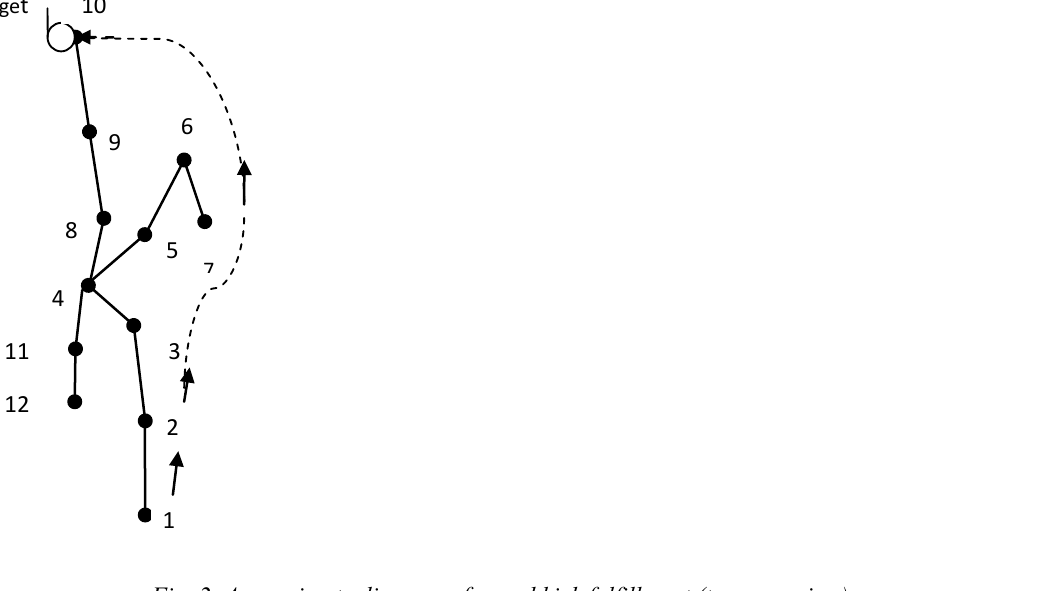
Fig. 2. Approximate diagram of round kick fulfillment (top-rear